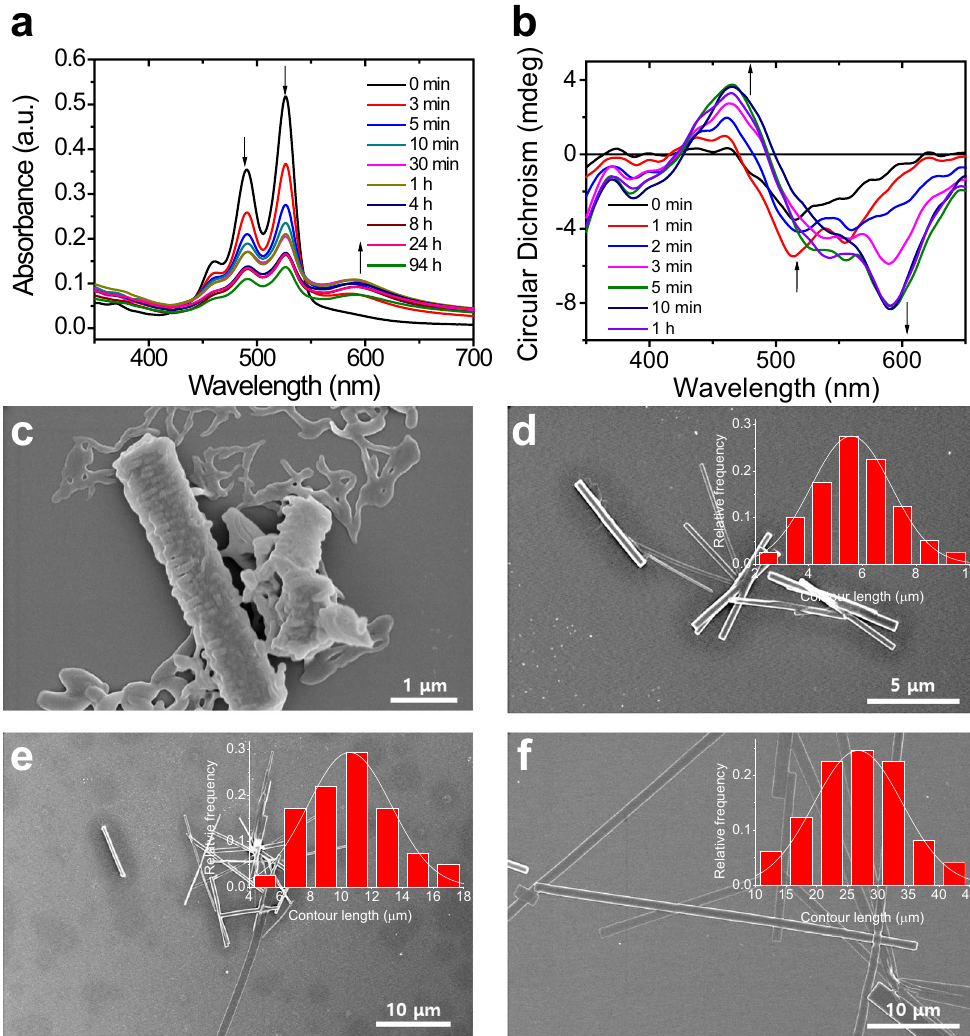
Figure 2. ( a ) Time-dependent UV-vis and ( b ) CD spectra of ( S )-CPDI-Ph in THF/water mixed solution (1.0 × 10 − 5 M) with f w = 60%. SEM images of ( S )-CPDI-Ph aggregates in THF/water mixed solution (1.0 × 10 − 5 M) with f w = 60% after ( c ) 10 s, ( d ) 3 min, ( e ) 10 min, and ( f ) 2